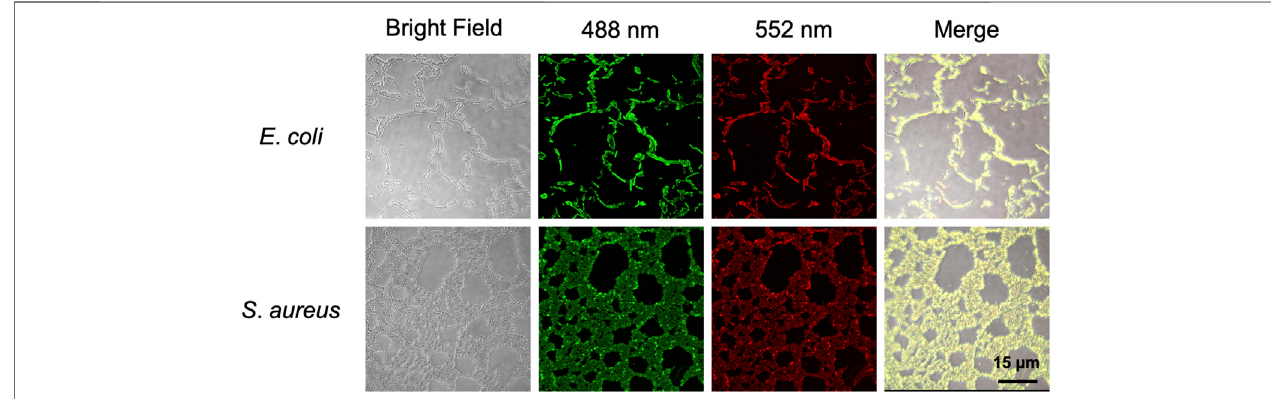
FIGURE 8 | Confocal microscopy images of E. coli ATCC 700926 and S. aureus ATCC 29213 treated with BAPTCDs. From left to right: bright fi eld, fl uorescent image excited with a 488 and 552 nm laser, and overlap, respectively.